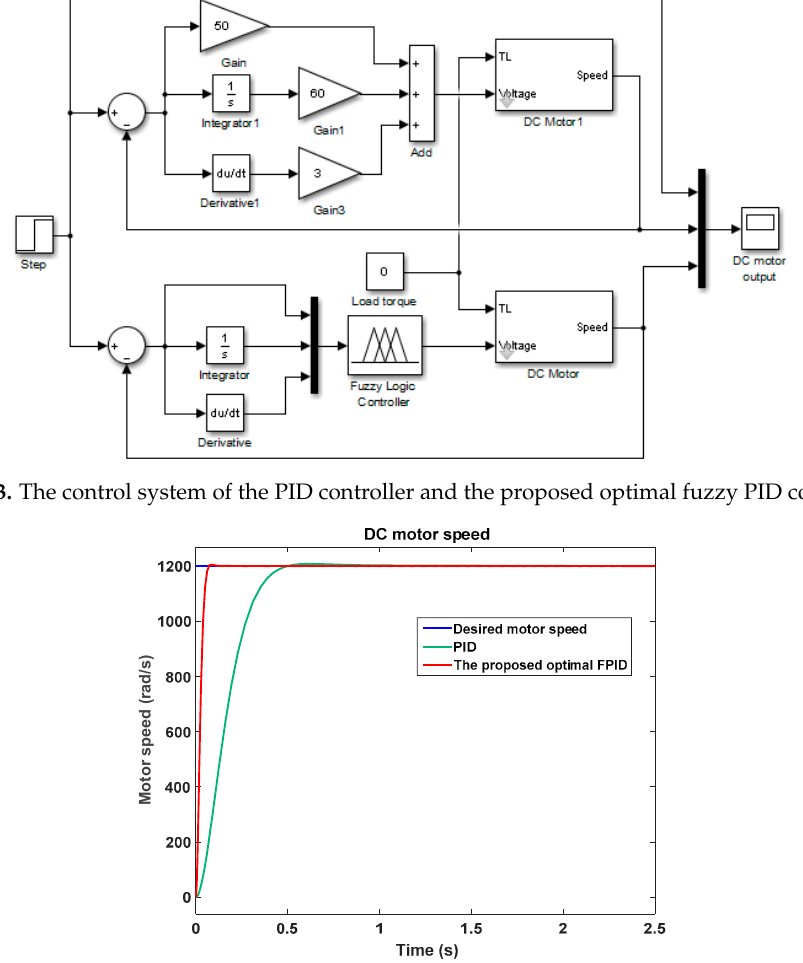
Figure 14. The motor speed control of the conventional PID controller and the proposed optimal fuzzy PID controller.